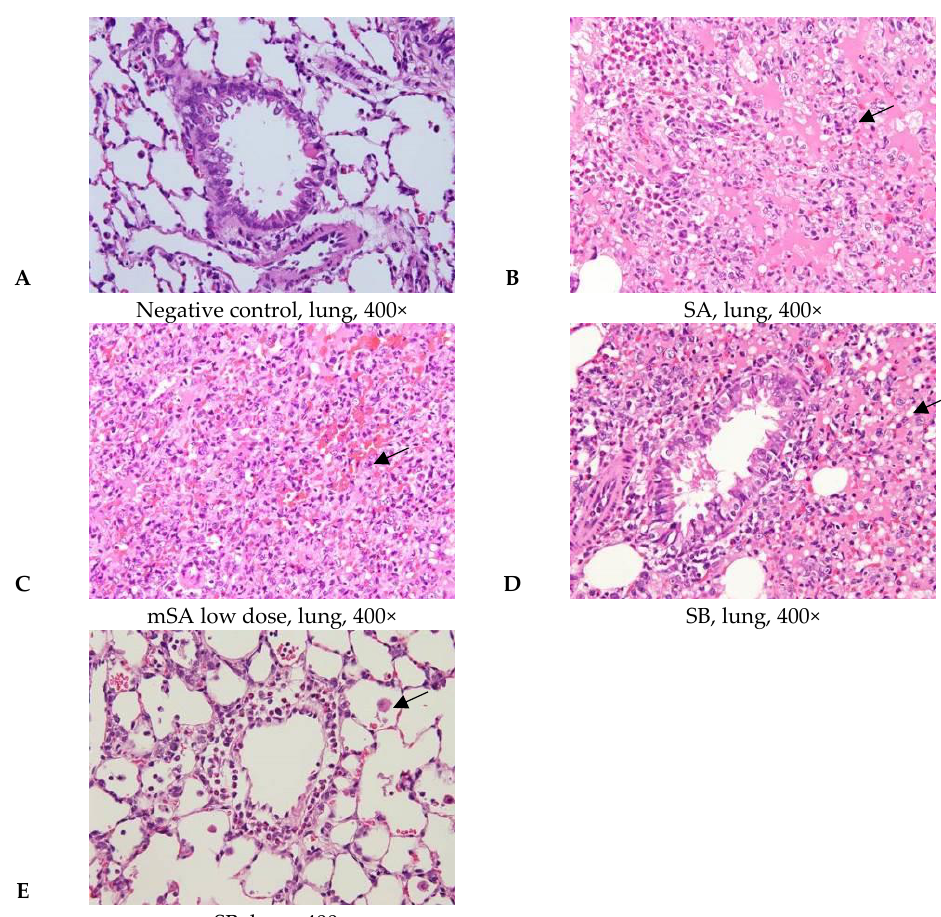
Figure 3. Histopathological changes of rats after intratracheal instillation with unmodified and modified nano-silica at Day 1 in the acute intratracheal instillation toxicity study. Normal architectures of lung in the control group ( A ), edema and inflammation of lung in the SA group ( B ), edema, hemorrhage, and inflammation of lung in the mSA low dose group ( C ), edema, hemorrhage, and inflammation of lung in the SB group ( D ), hemorrhage and inflammation of lung in mSB group ( E ) were found in rats at Day 1. H&E stain. Negative control: R.D.W, 0.5 mL/kg bw, i.t.; SA: sample A, 2.58 mg/kg bw, 80× diluted, 0.5 mL/kg bw, i.t.; mSAL: modified sample A low dose, 0.06 mg/kg bw, 320× diluted, 0.5 mL/kg bw, i.t.; SB: sample B, 2.24 mg/kg bw, 80× diluted, 0.5 mL/kg bw, i.t.; mSB: modified sample B, 0.24 mg/kg bw, 80× diluted, 0.5 mL/kg bw, i.t. H&E stain. 400×. Arrow.